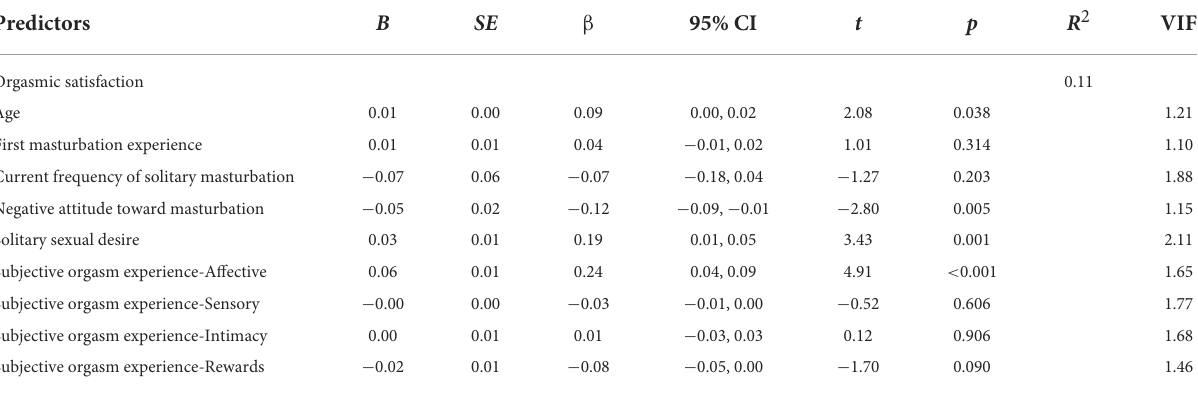
TABLE 4 Multiple regression models for orgasmic satisfaction in